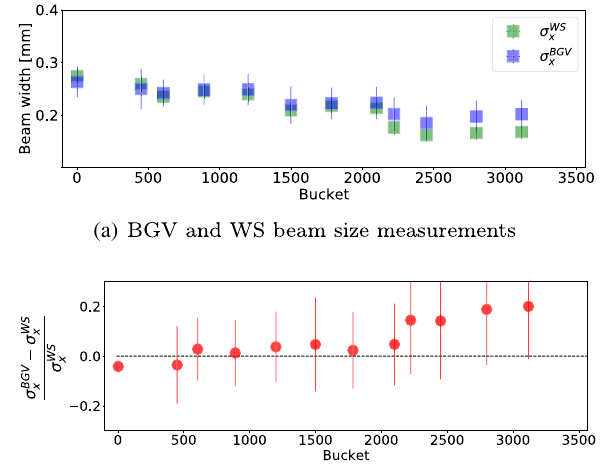
FIG. 17. BGVand WS beam size measurements comparison for individual LHC proton bunches. Data were taken during a special calibration run at 6.5